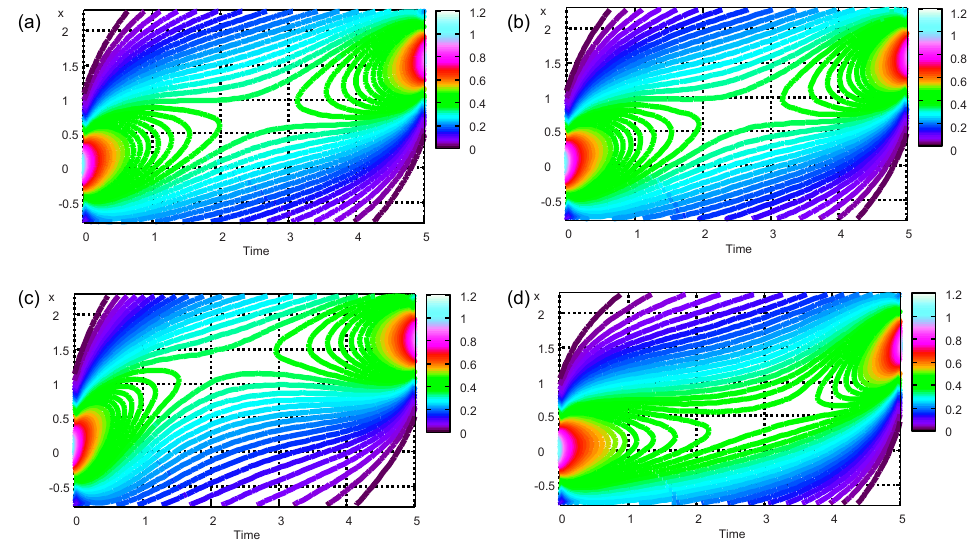
Figure 1. Probability density of paths derived by MCMC and PS for the hyperbolic model. (a) Reference solution by PS, (b) solution by MCMC with scheme E or TD, (c) solution by MCMC with scheme ED, and (d) solution by MCMC with scheme T.